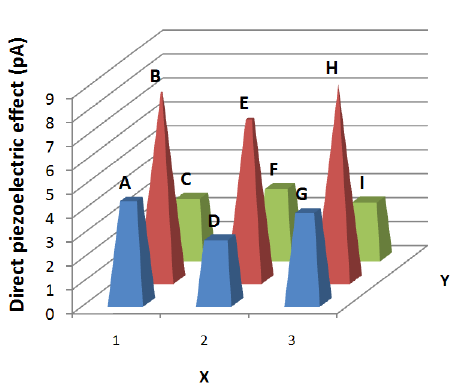
Figure 10. Electrical current generated by a force of 53 mN in six zones.